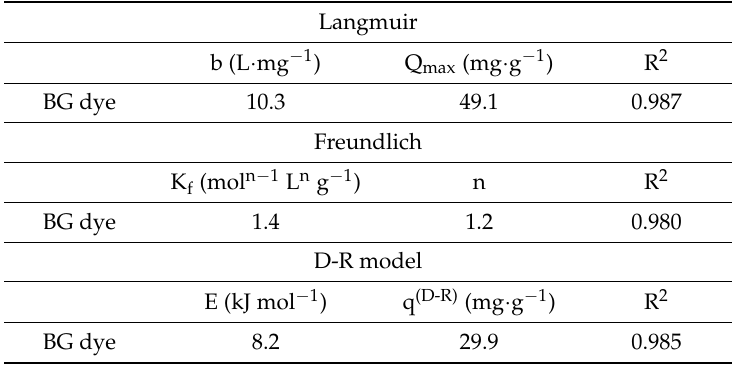
Table 2. Isothermal parameter for the sorption of BG dye onto Hap/CS